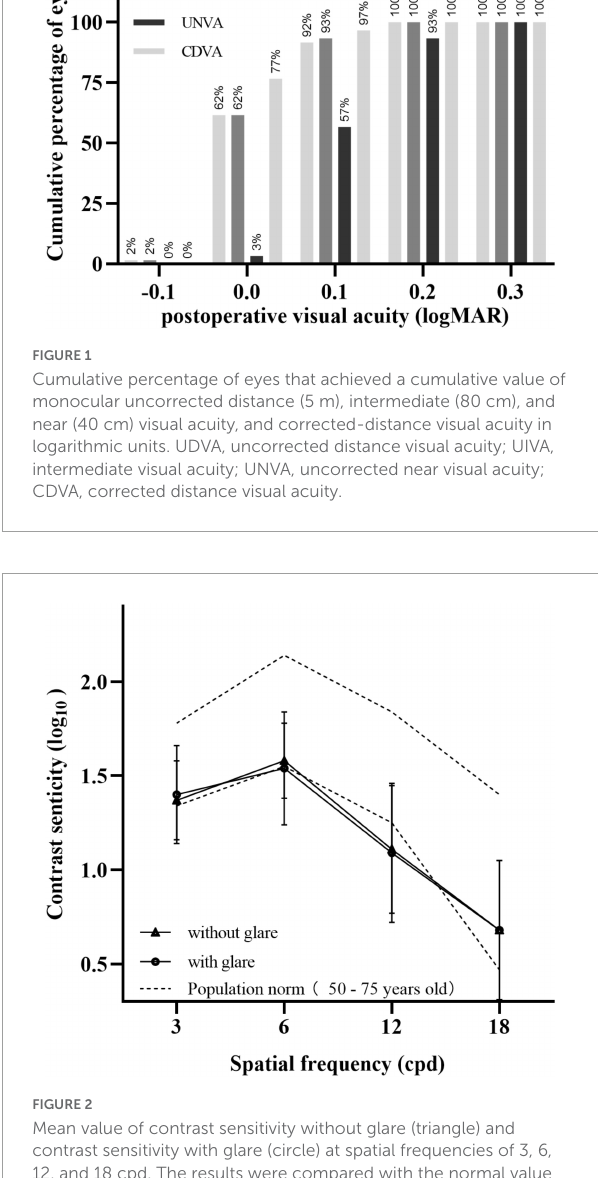
TABLE 1 Pre- and post-operative data of patients.